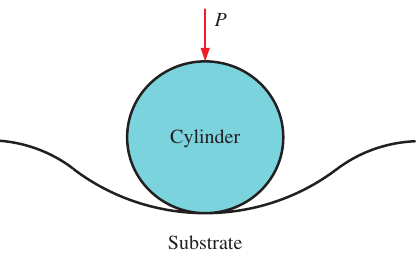
Figure 7 Schematic of the indentation of a rigid cylinder on an elastic half space